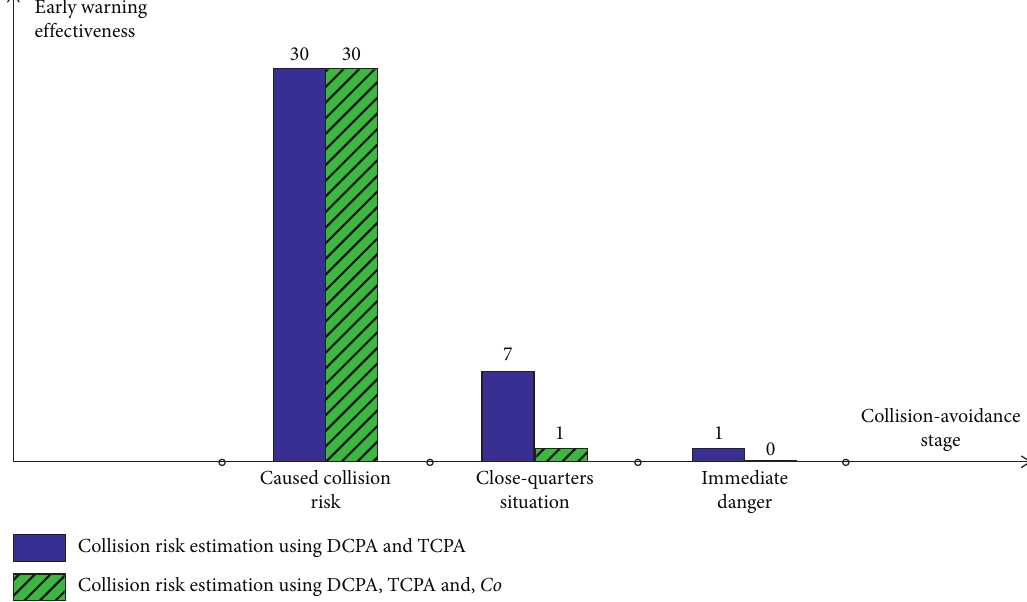
Figure 9: Comparison of the effectiveness of an early warning system for two ships in an inland waterway proposed in this study.